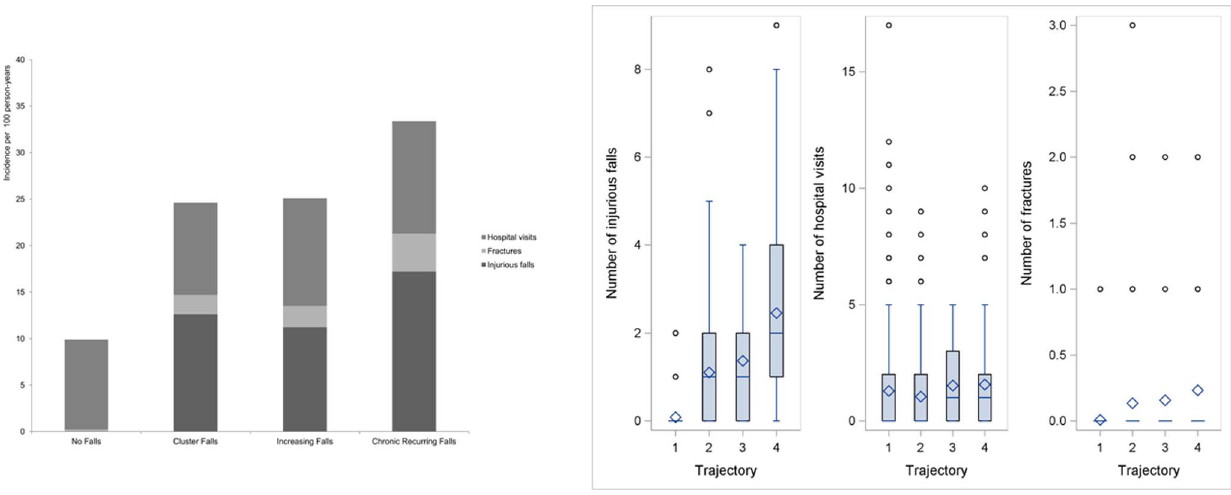
Figure 2. Clinical Outcomes according to Falls Trajectory group membership (The MOBILIZE Boston Study). A. Incidence Rate of Clinical Outcomes according to Falls Trajectory Group. B. Box plot showing Averages of Clinical Outcomes according to Falls Trajectory Group: Trajectories : 1=No Falls; 2=Cluster Falls; 3=Increasing Falls; 4= Chronic Recurring Falls. Injurious Falls : 2&4 p , 0.001 (S); 3&4 p , 0.001 (S); All others NS. Hospital visits : All are NS. Fractures : 1&2 p , 0.001 (S), 1&3 p , 0.001 (S), 1&4 , 0.0001, All others are NS.